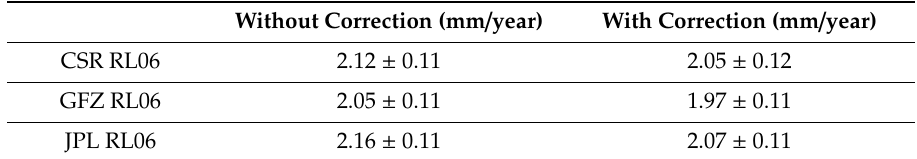
Table 2. The GMOM rates from Center for Space Research (CSR), Geoforschungszentrum (GFZ), and Jet Propulsion Laboratory (JPL) RL06 solutions for the period January 2003 to December 2015. The uncertainties are from 2 sigma of the least-squares fitting. Without Correction (mm / year) With Correction (mm /